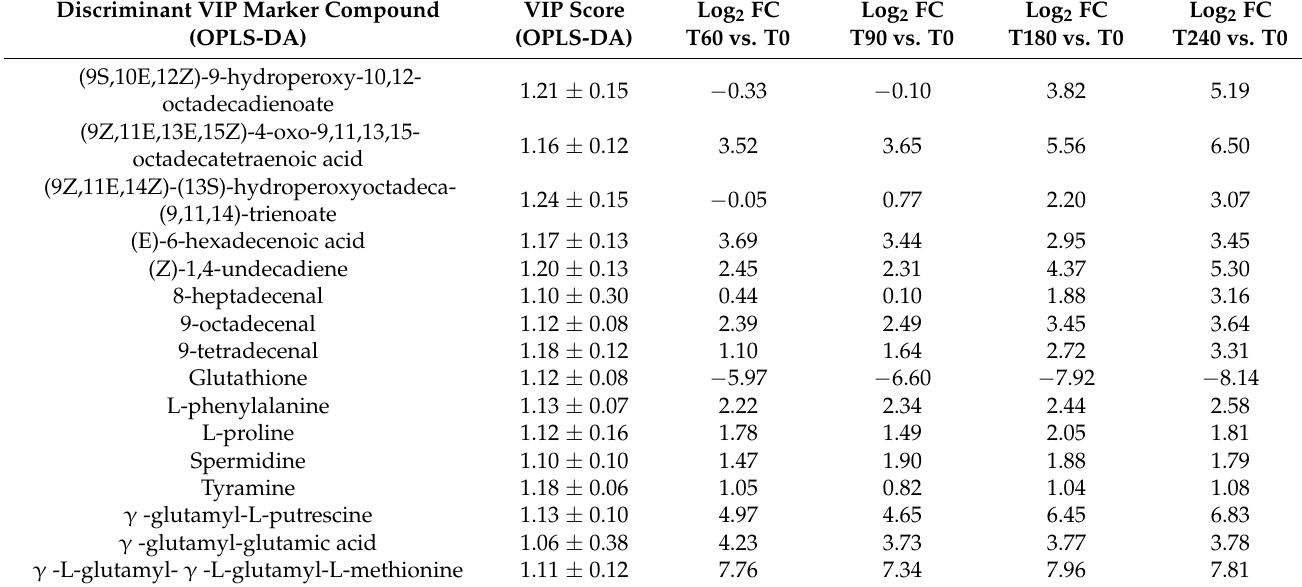
Table 3. Significant VIP marker compounds related with oxidation processes characterizing the chem- ical modifications of the different Coppa Piacentina PDO samples during ripening. Each discriminant compound is reported with its VIP score (prediction ability) and Log 2 FC value against